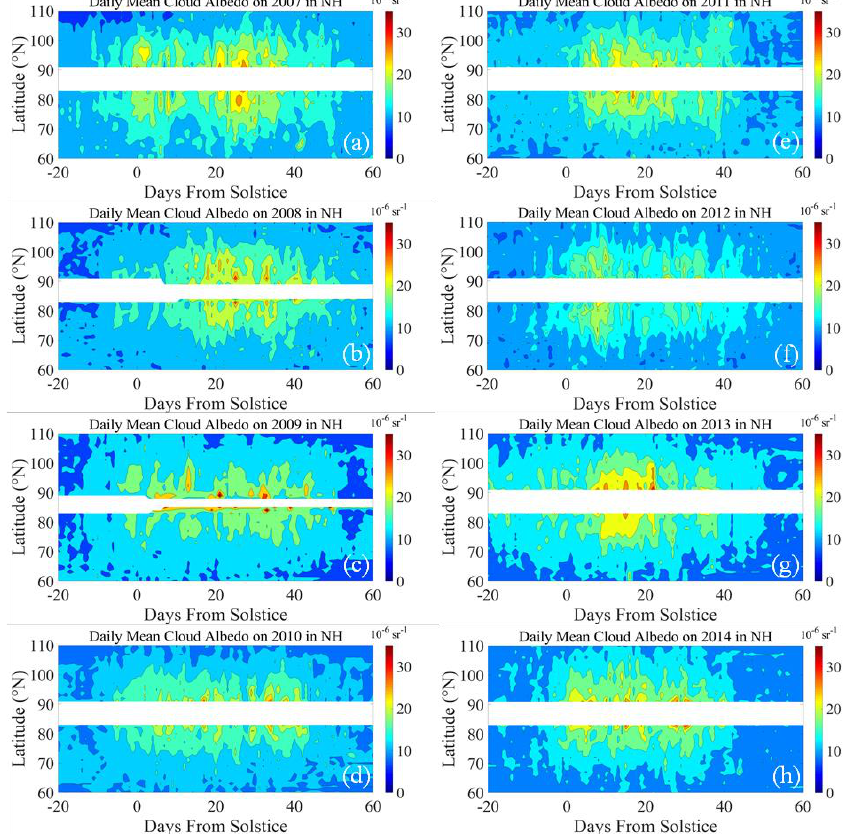
Figure 7. The cloud albedo distributions of the PMC seasons from 2007 to 2014 in the NH. (a) Cloud albedo on 2007 PMC season; (b) Cloud albedo on 2008 PMC season; (c) Cloud albedo on 2009 PMC season; (d) Cloud albedo on 2010 PMC season; (e) Cloud albedo on 2011 PMC season; (f) Cloud albedo on 2012 PMC season; (g) Cloud albedo on 2013 PMC season; (h) Cloud albedo on 2014 PMC season.